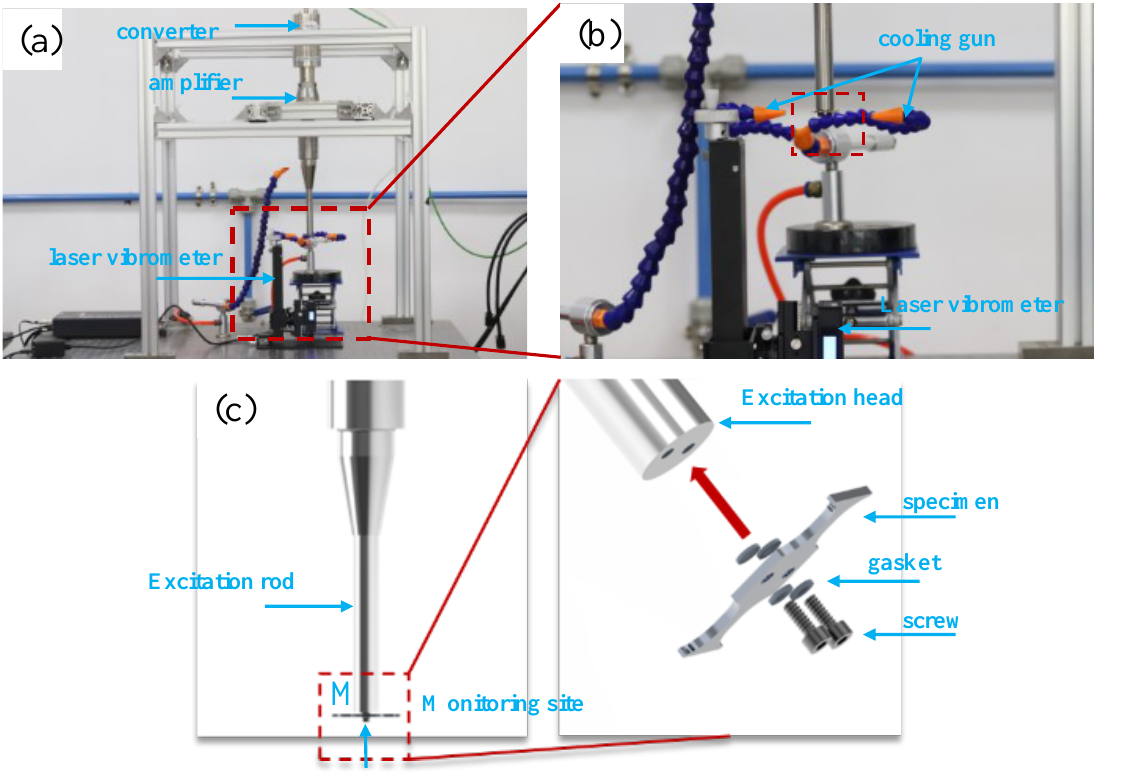
Figure 6. Bending test based on ultrasonic fatigue system: ( a ) full view of the system; ( b ) details of the constraint; ( c ) composition of the bending constraint method.